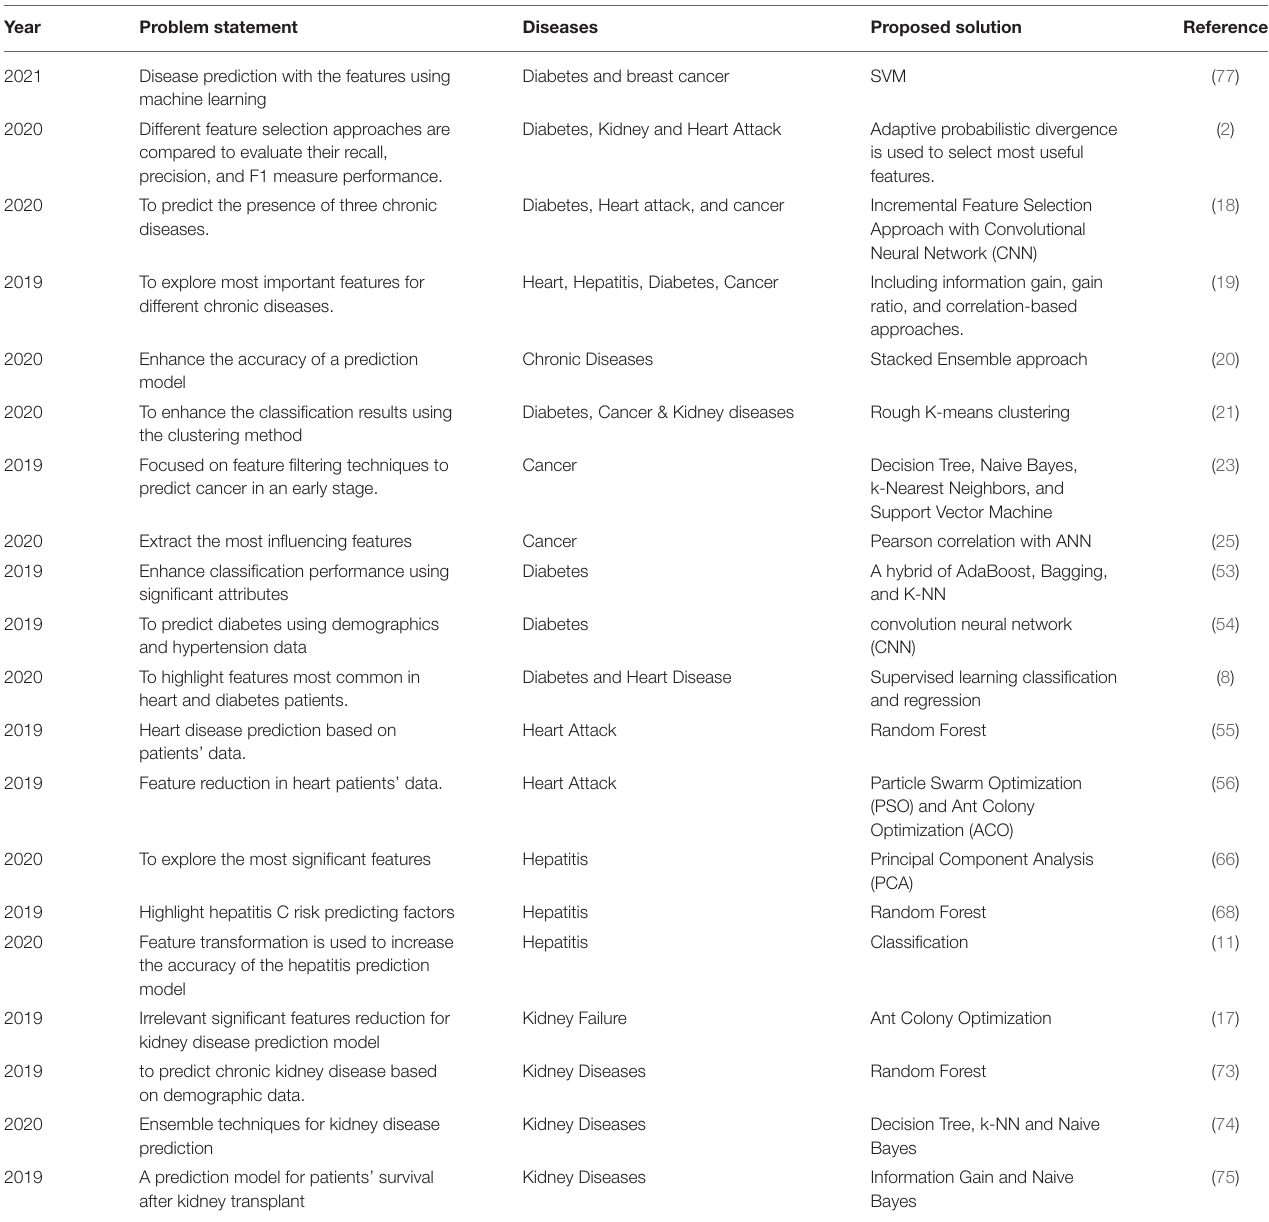
TABLE 1 | Summary of the literature